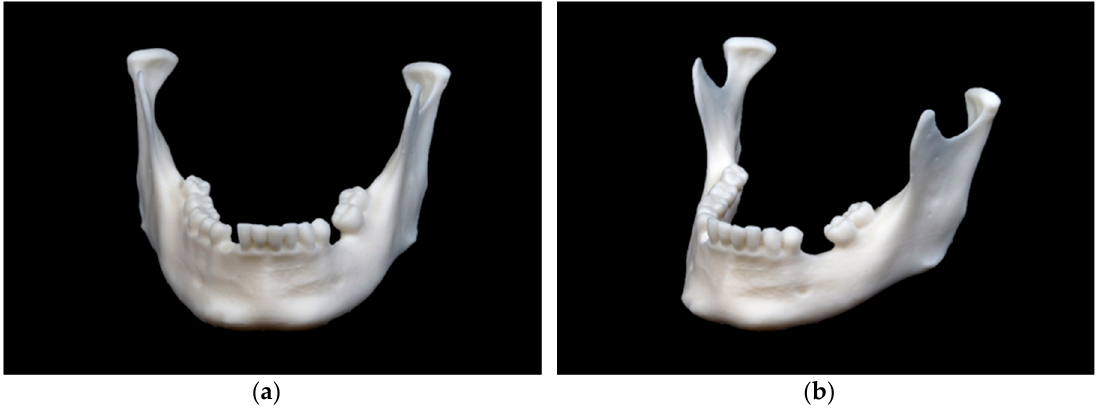
Figure 4. Mandibular model printed in stereolithography (SLA) technology: ( a ) front view; ( b ) side view.